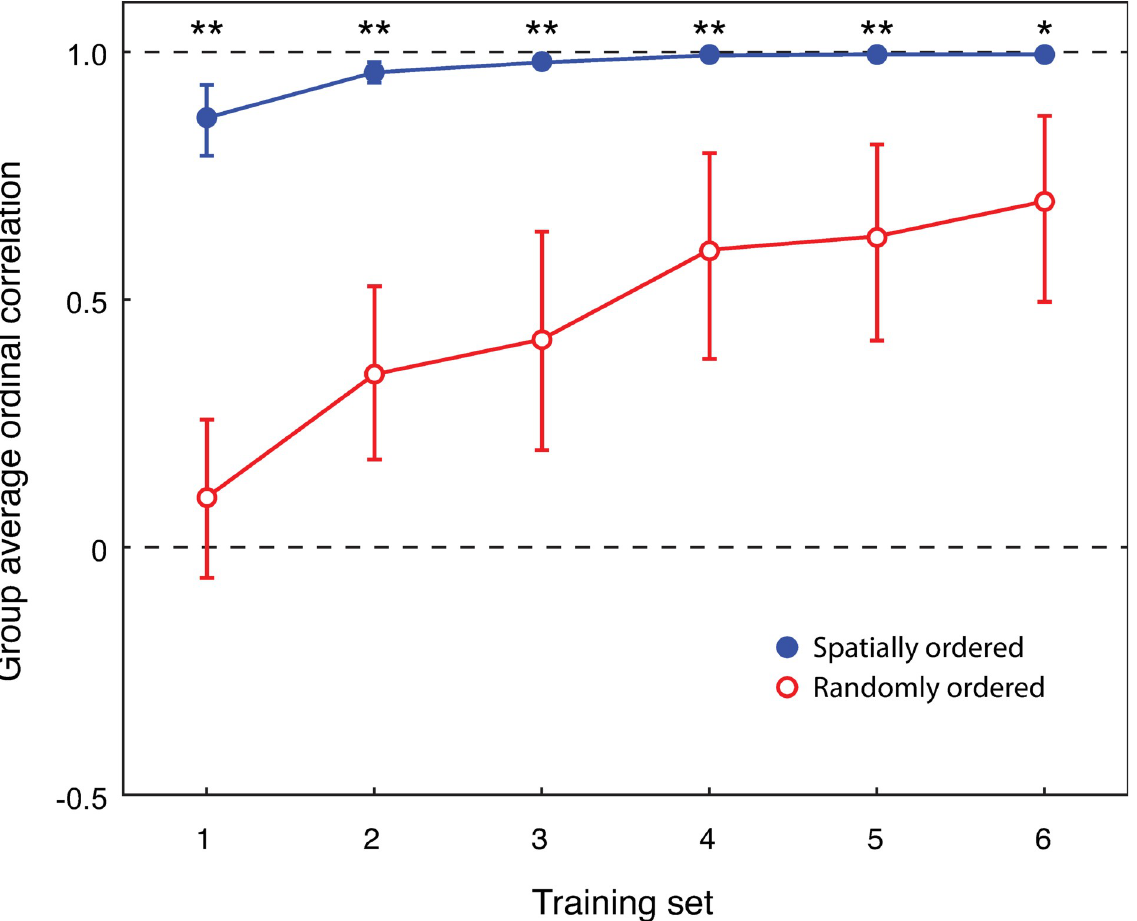
Fig 2. Group average Spearman’s rank order correlations (y-axis) for both the spatially ordered group (filled blue circle) and the randomly ordered group (open red circle), as a function of training session (x-axis). The error bars represent the 95% CI. The dashed lines are for correlations of 0 (no correlation) and 1.0 (perfect correlation). Two stars is significance at the p < .01 level, and one star is significance at the p < .05 level. Several participants did not complete the six training blocks within the 25 minute time allo- cated for the session ( n = 2 in the spatial complexity group, and n = 8 in the random complex- ity group). For these participants, the last correlation they achieved was used to replace missing blocks. Correlations were calculated for each participant between their ordering in each block and the ‘correct’ order. Examining the means and 95% confidence intervals (CIs), the spatial complexity group (blue) outperformed the random complexity group (red). The spatial complexity group learned the correct order quickly and consistently; block 1 = 0.87 [0.80, 0.94], block 2 = 0.96 [0.94, 0.98], block 3 = 0.98 [0.97, 0.99], block 4 = 0.99 [0.99, 1.00], block 5 = 1.00 [0.99, 1.00], and block 6 = 1.00 [0.99, 1.00], often achieving near perfect perfor- mance from the second training block, with an average correlation of 1.00 by the sixth training block. In contrast, the random complexity group displayed much slower learning; block 1 = 0.10 [-0.05, 0.26], block 2 = 0.35 [0.18, 0.53], block 3 = 0.42 [0.20, 0.64], block 4 = 0.60 [0.38, 0.82], block 5 = 0.63 [0.42, 0.83], and block 6 = 0.70 [0.49, 0.90], achieving an average correlation of only 0.70 by the sixth training block.